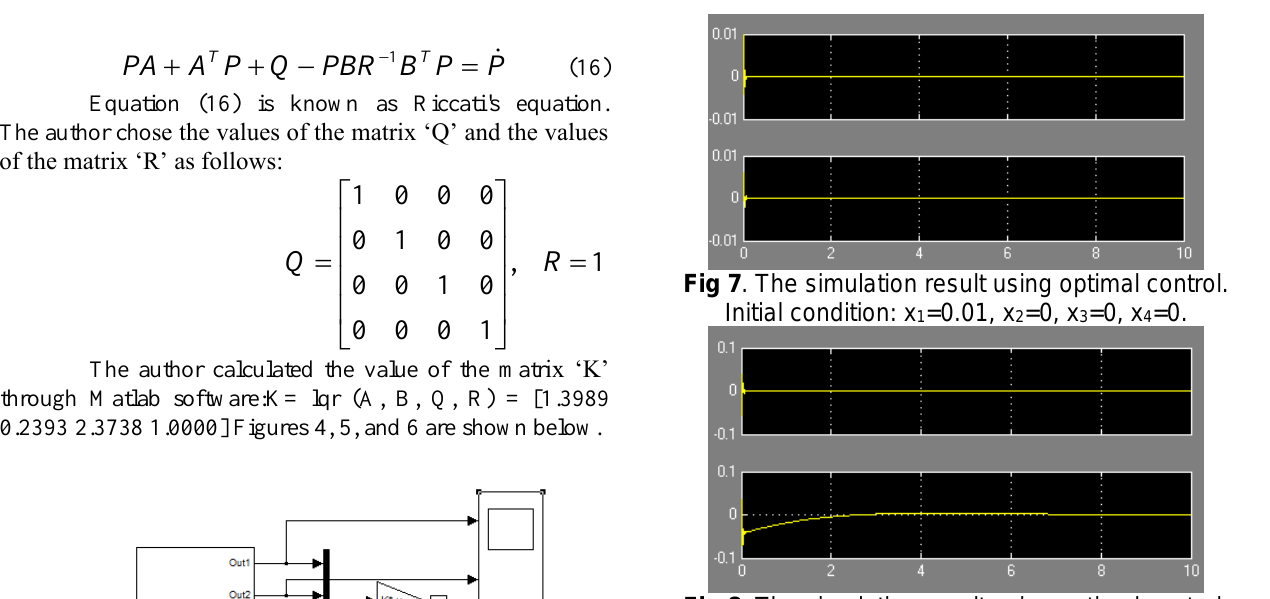
Fig 8 . The simulation result using optimal control.